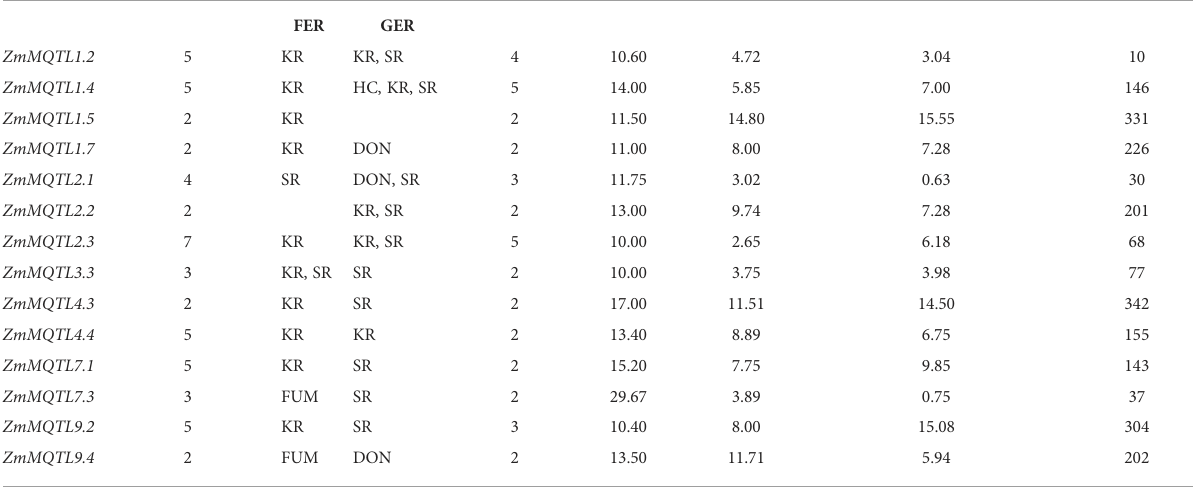
TABLE 7 Selected meta-QTL (MQTL) and corresponding candidate genes (CG). MQTL